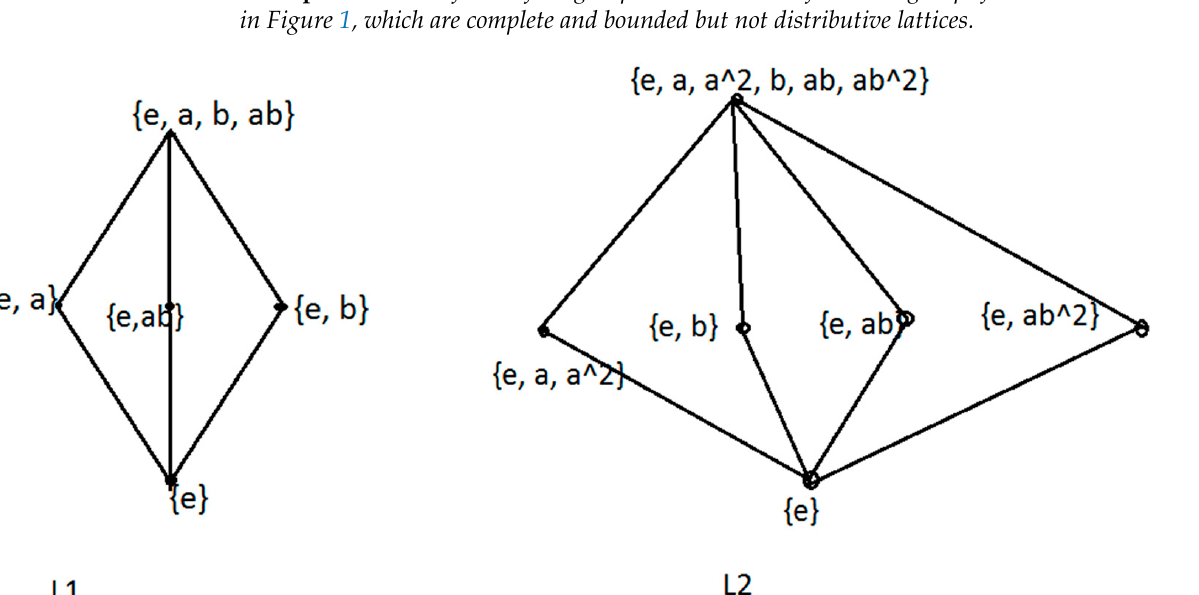
Figure 2. Complete bounded distributive lattices . Definition 7 [2]. An L-FS 𝐺 on a non-empty set 𝛹 is a function 𝐺: 𝛹 → 𝐿, where 𝐿 is a bounded complete distributive lattice, along with 1 (cid:3013) and 0 (cid:3013) . Remark 1. If 𝐿 = [0,1] , then the 𝐿 -FS becomes an FS in the sense of Zadeh. Hence, the class of 𝐿 -FSs is larger than the class of FSs. Definition 8 [2]. The 𝛼 (cid:3013) -level set of an L-FS 𝐺 is denoted by [𝐺] (cid:3080) (cid:3261) and is defined as below: [𝐺] (cid:3080) (cid:3261) = (cid:3419)𝑢 ∈ Ψ ∶ 𝛼 (cid:3013) ⪯ (cid:3013) 𝐺(𝑢), for 𝛼 (cid:3013) ∈ 𝐿\{0 (cid:3013) }(cid:3423) [G] (cid:2868) (cid:3261) = {𝑢 ∈ Ψ ∶ 0 (cid:3013) ⪯ (cid:3013) 𝐺(𝑢)}(cid:3364)(cid:3364)(cid:3364)(cid:3364)(cid:3364)(cid:3364)(cid:3364)(cid:3364)(cid:3364)(cid:3364)(cid:3364)(cid:3364)(cid:3364)(cid:3364)(cid:3364)(cid:3364)(cid:3364)(cid:3364)(cid:3364)(cid:3364)(cid:3364)(cid:3364)(cid:3364)(cid:3364)(cid:3364)(cid:3364)(cid:3364) where 𝑆̅ is the closure of the set 𝑆 (crisp set). Let 𝐹 (cid:3013) (Ψ) be the set of all L -FSs in Ψ . Now, for 𝑥 ∈ Ψ, 𝐴, 𝐵 ∈ 𝐹 (cid:3013) (Ψ), 𝛼 (cid:3013) ∈ 𝐿\{0 (cid:3013) } and [𝐴] (cid:3080) (cid:3261) , [𝐵] (cid:3080) (cid:3261) ∈ 𝐶𝐵(Ψ), we define: 𝑝 (cid:3080) (cid:3261) (𝑥, 𝐴) = 𝑖𝑛𝑓(cid:3419)𝑑(𝑥, 𝑎). ; 𝑎. ∈ [𝐴] (cid:3080) (cid:3261) (cid:3423) 𝑝 (cid:3080) (cid:3261) (𝐴, 𝐵) = 𝑖𝑛𝑓(cid:3419)𝑑(𝑎, 𝑏). ; 𝑎 ∈ [𝐴] (cid:3080) (cid:3261) , 𝑏. ∈ [𝐵] (cid:3080) (cid:3261) (cid:3423)